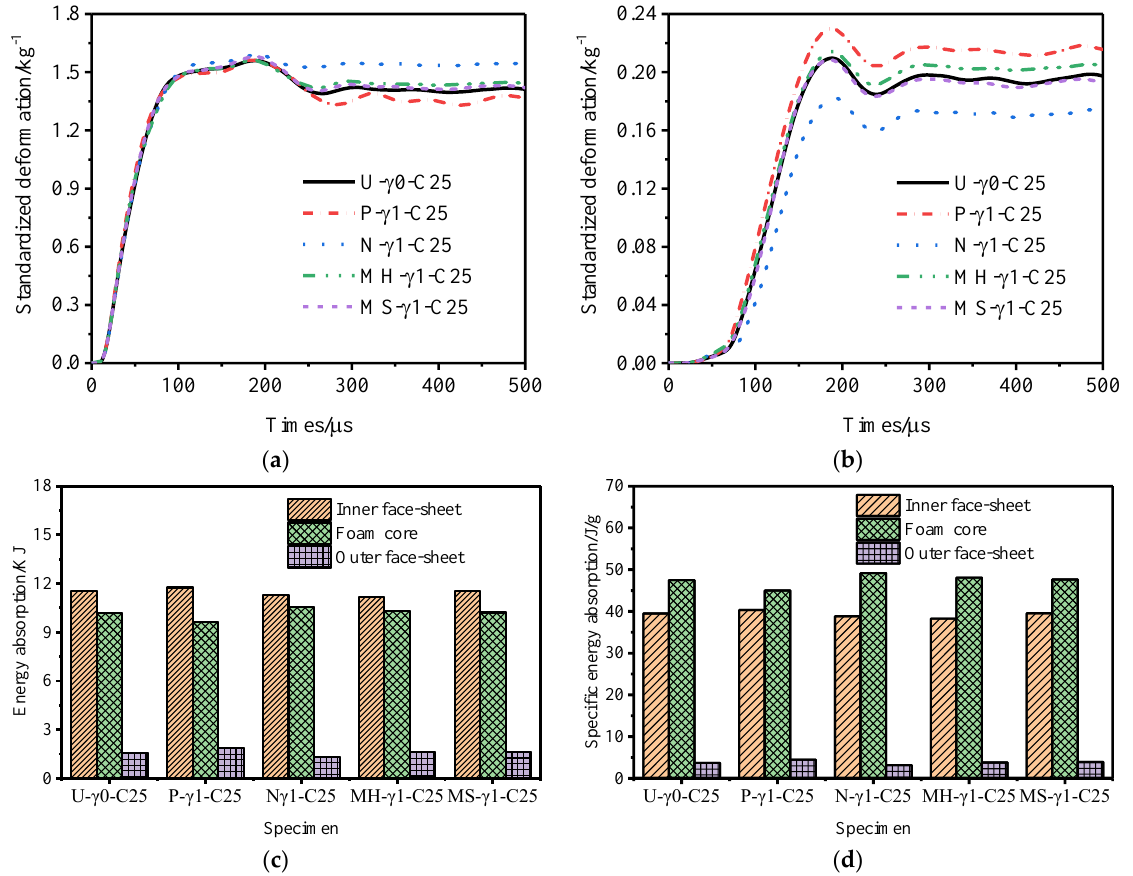
Figure 22. Anti − explosion performance of a foamed aluminum sandwich tube when the core thickness is 25 mm. ( a ) Deformation curve of the inner tube, ( b ) deformation curve of the outer tube, ( c ) total energy absorption of the sandwich tube, and ( d ) specific energy absorption of the sandwich tube.